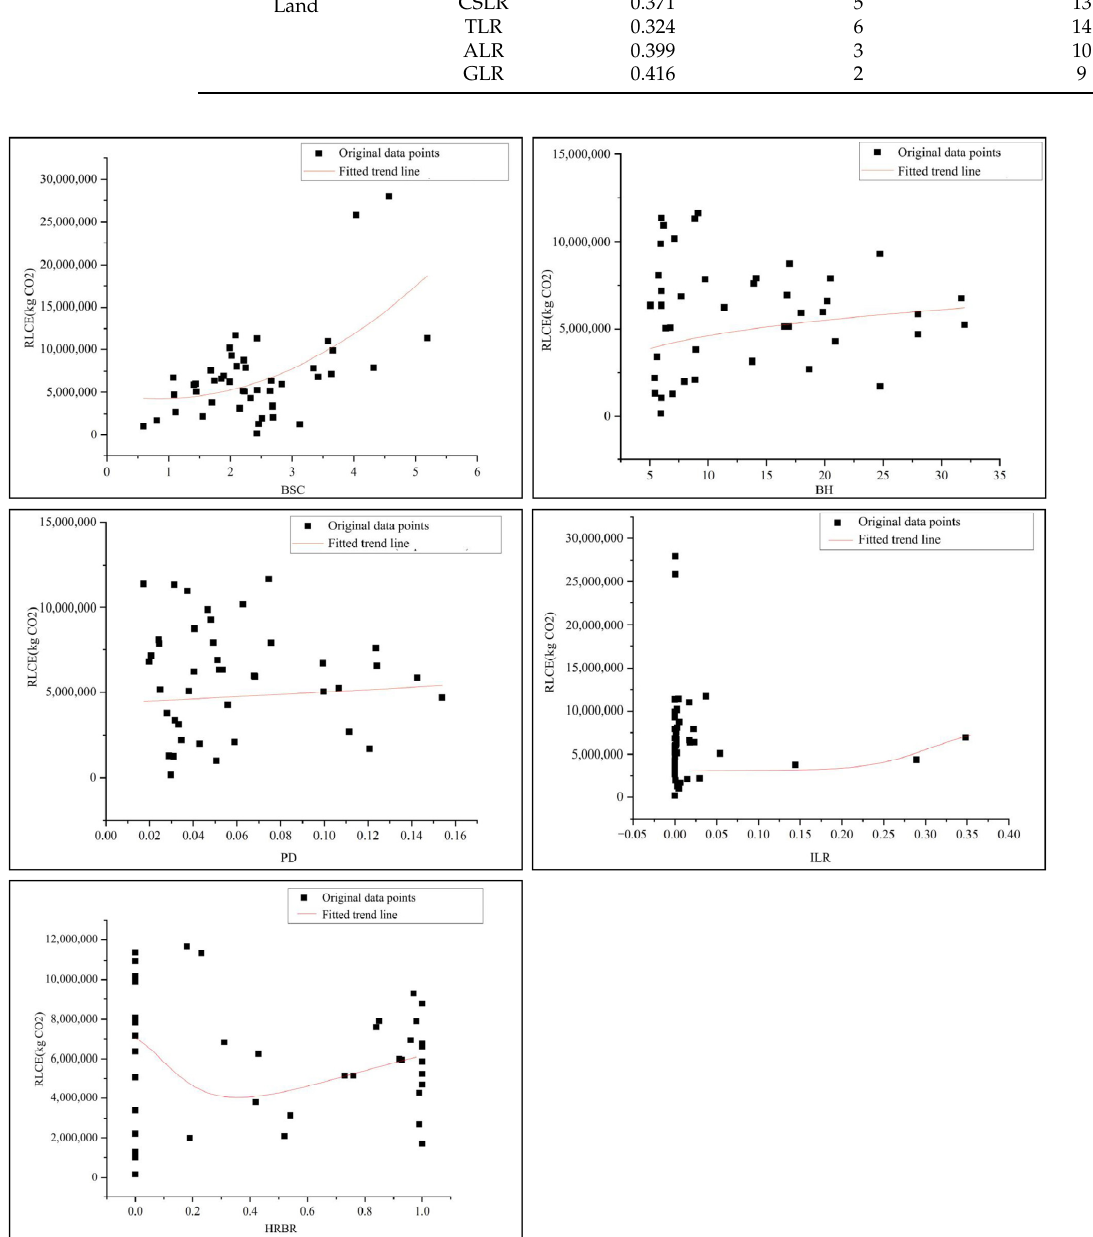
Figure 7. Fitted value and trend line of BSC, BH PD, ILR, HRBR, and